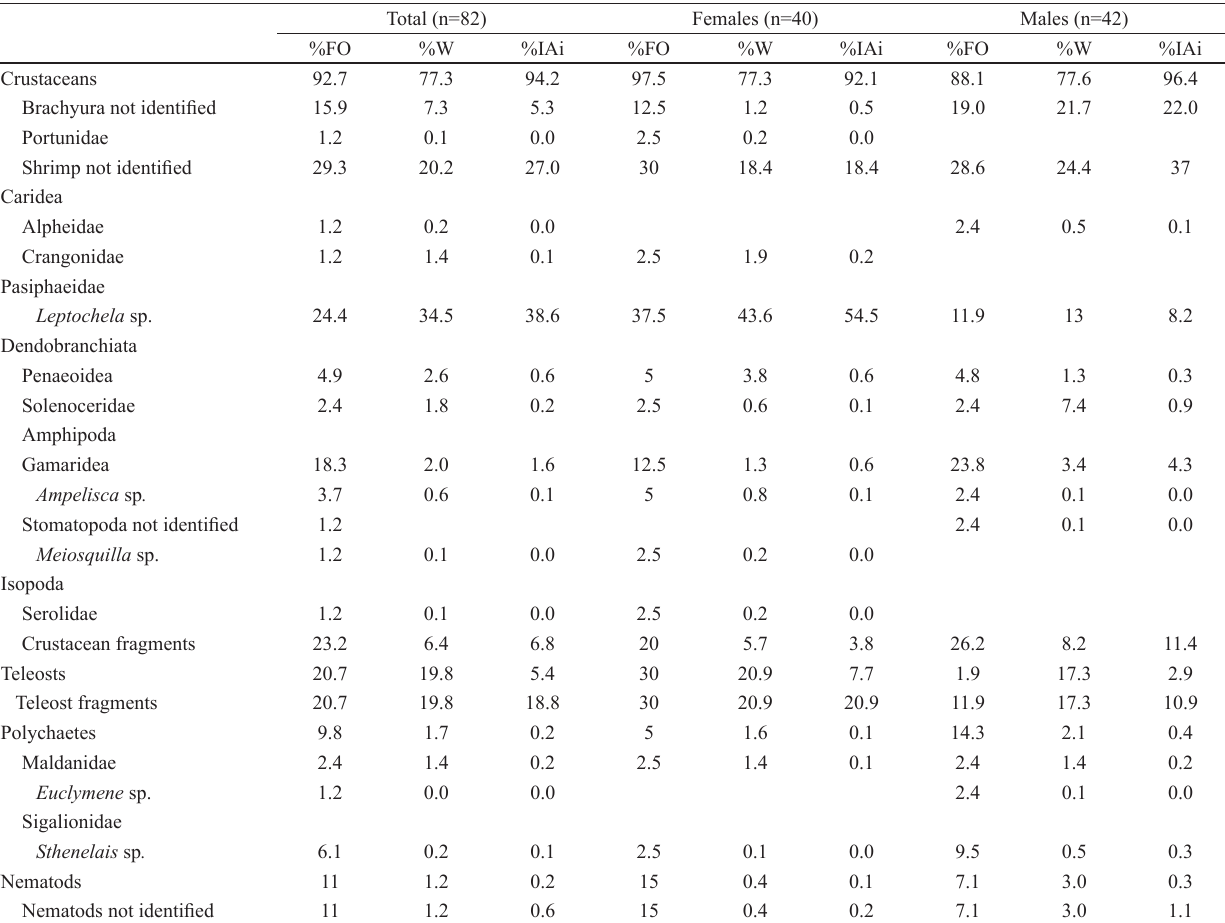
Tab. 3. Frequency of occurrence (%FO), percentage weight (%W) and alimentary index (%IAi) of prey items in the total diet of Psammobatis extenta in the southeastern Brazil, between January 2006 and August 2007, total and according to